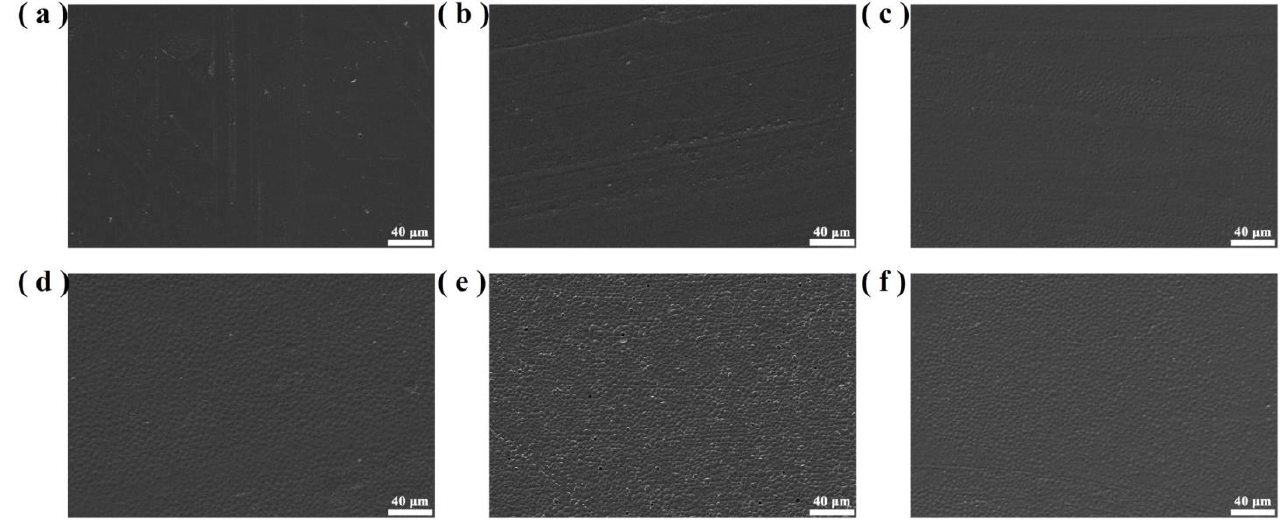
Figure 10. Microscopic morphology of PO3G–PA/PLLA composite films with different ratios. ( a ) Pure PLLA; ( b ) 5PO3G–PA/PLLA; ( c ) 10PO3G–PA/PLLA; ( d ) 15PO3G–PA/PLLA; ( e ) 20PO3G– PA/PLLA; ( f ) 25PO3G–PA/PLLA.